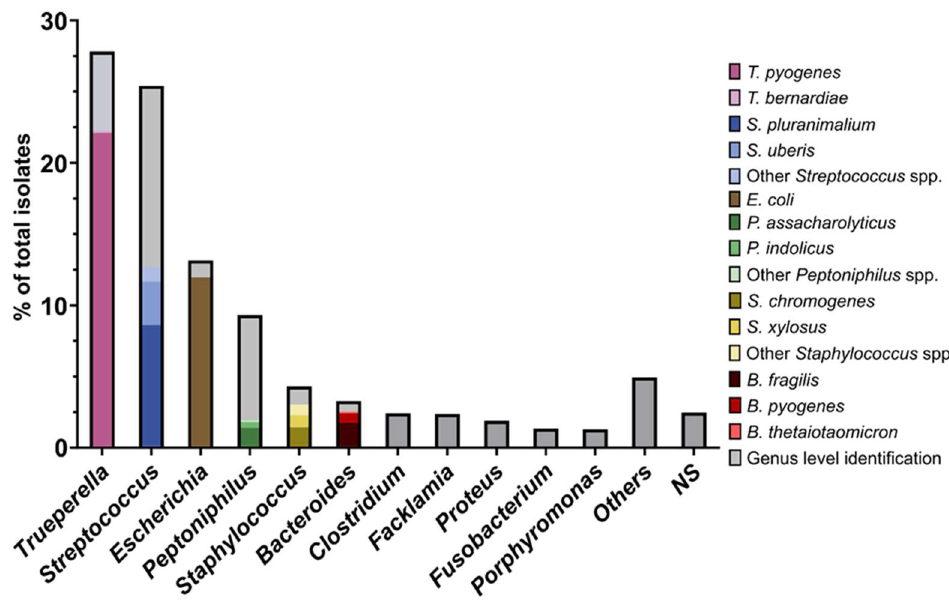
Figure 2. Composition of the anaerobic cultivable microbiota found in the postpartum bovine uterus during the first 28 days postpartum. Relative abundance was calculated for genera with prevalence higher than 1% ( n = 1858 isolates). In addition, relative abundances are shown on species level for the six most frequently isolated genera. Genera representing less than 1% of the total number of isolates were combined as others. NS (potentially new species): bacteria showing <98.65% 16S rRNA similarity to the next phylogenetic relative species and may potentially represent a new taxa.